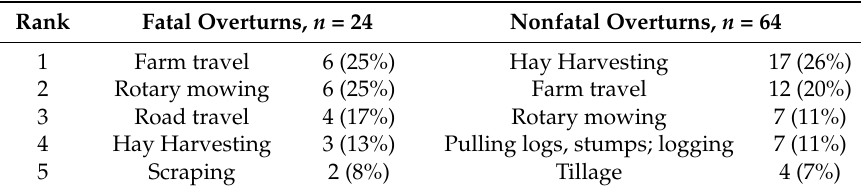
Table 3. Top five chores associated with fatal and nonfatal injury overturns of tractors without rollover protective structures.